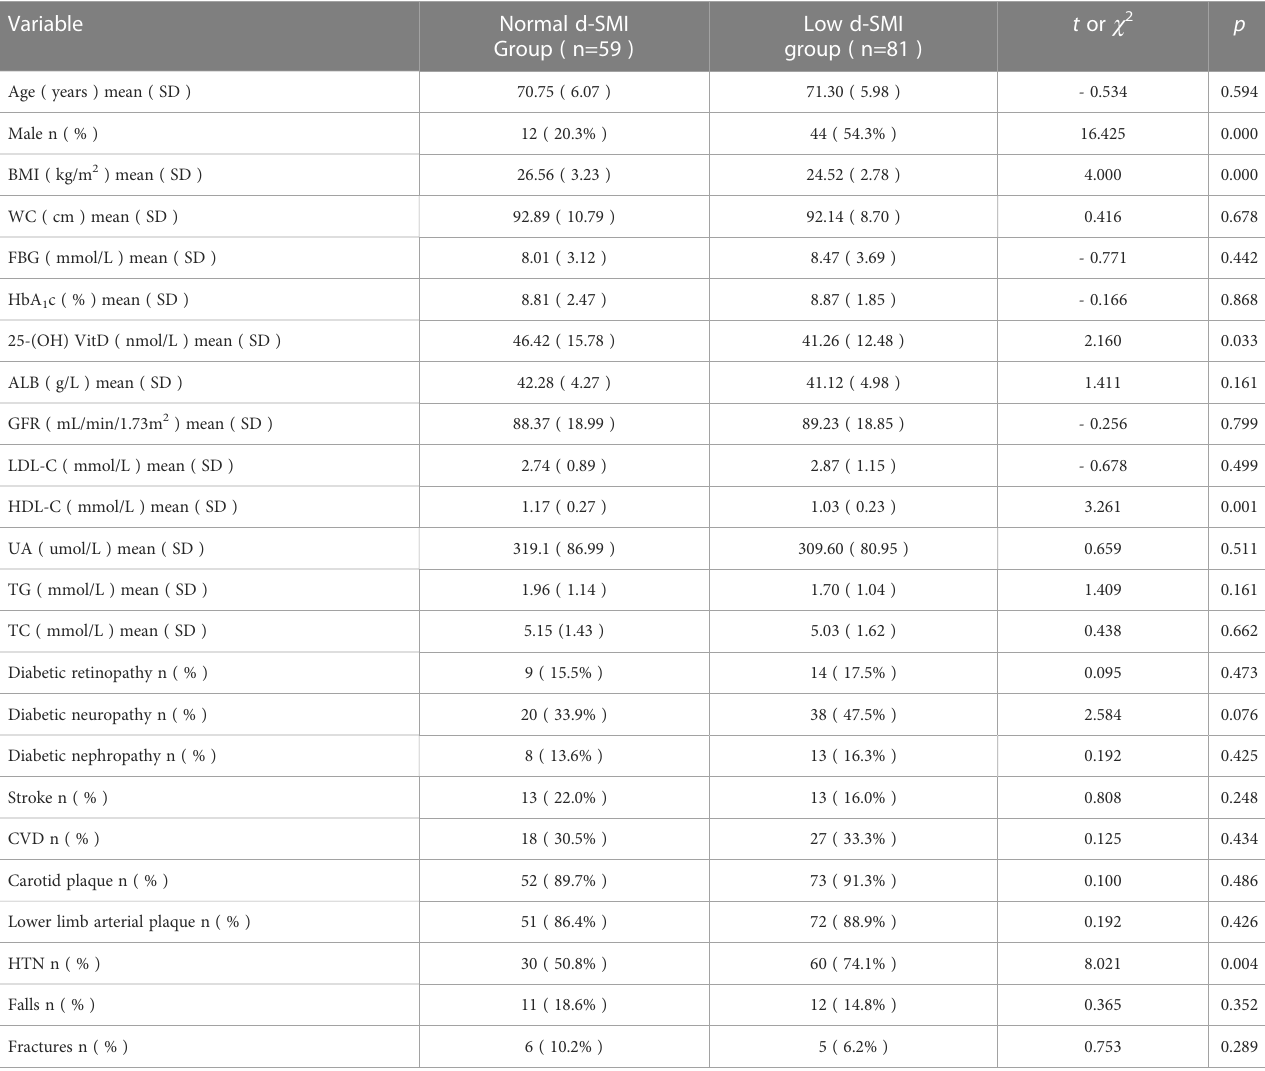
TABLE 2 Baseline characteristics of normal d-SMI and low d-SMI patients.